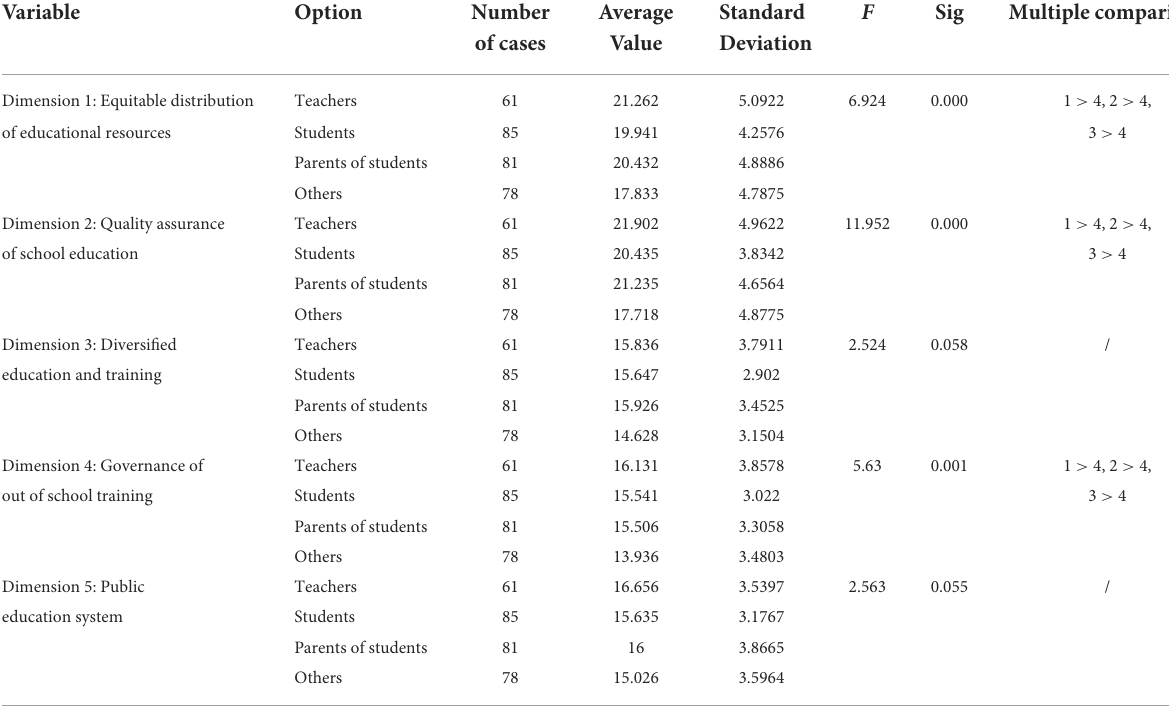
TABLE 11 Analysis of differences in investigator identity of data from various dimensions. Variable Option Number